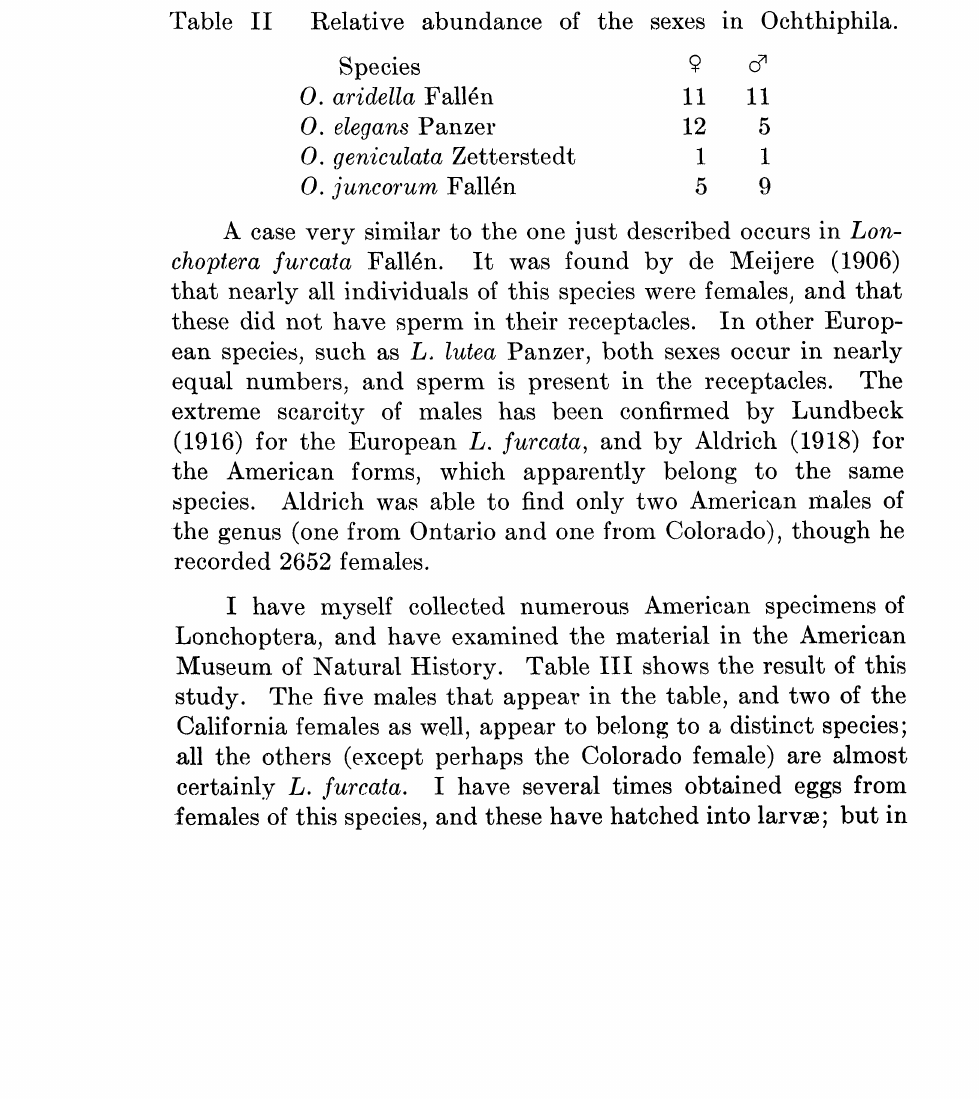
Relative abundance of the sexes in